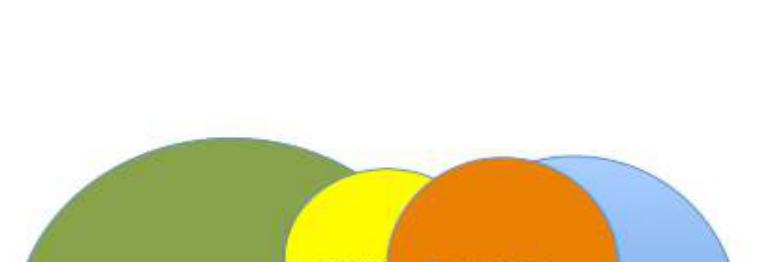
Diagram 3: the overlapping spheres in the digital